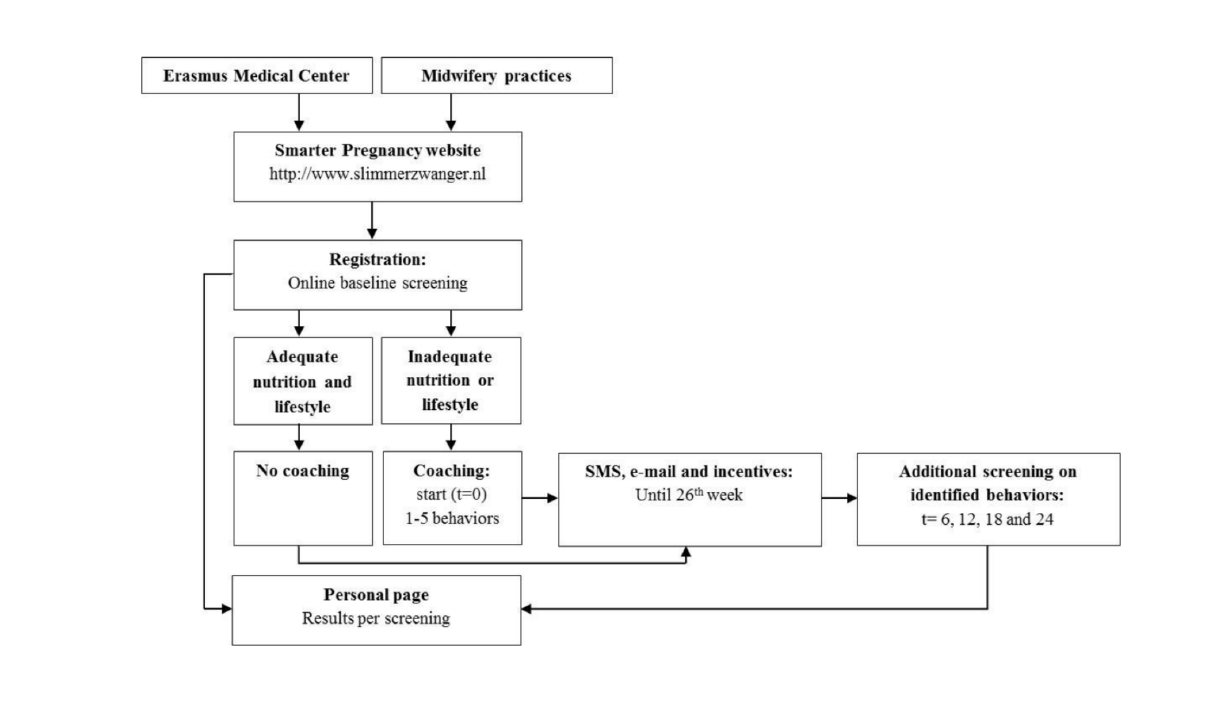
Figure 1. Overview of the Web-based Smarter Pregnancy program: registration, identification of inadequate nutrition and lifestyle behaviors, and coaching. SMS: short message